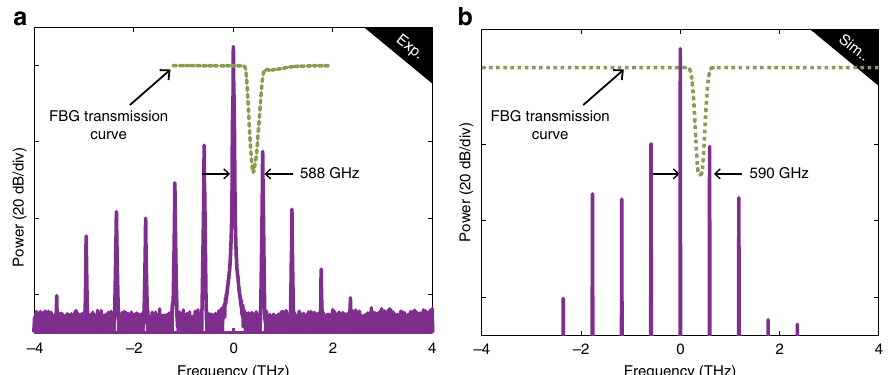
Fig. 2 GTF comb. Optical frequency comb at the cavity output for λ P = 1544.66 nm a in experiments and b in numerics. The green dashed lines represent the modulus square of the transfer function of the notch fi lter